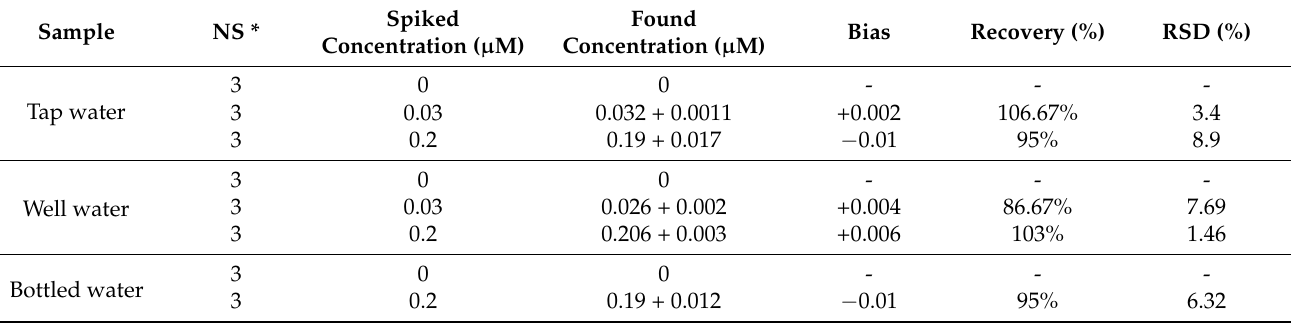
Table 1. The result of real sample